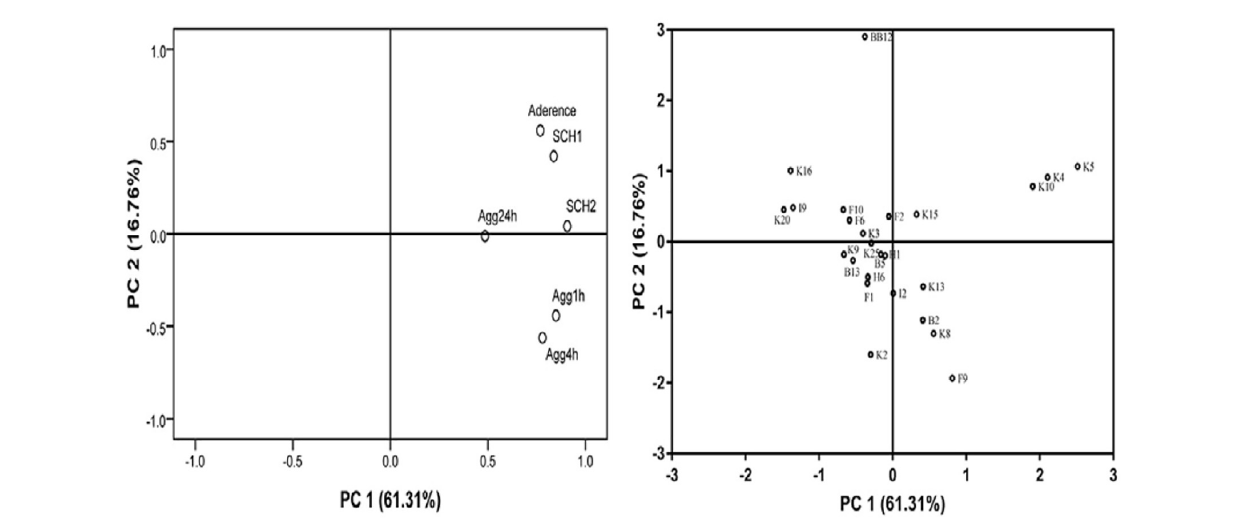
FIGURE 5 | Loading plot of principal component analysis. The image in the left is loading plot represented for six independent assays of adhesion properties: autoaggregation in 1 h (Agg1 h), autoaggregation in 4 h (Agg4 h), autoaggregation in 24 h (Agg24 h), cell surface hydrophobicity level in xylene (CSH1) and ethyl acetate solution (CSH2), and adhesion property to HT-29 cells. The image in the right is score plot of the adhesion properties of B. longum subsp. longum strains.